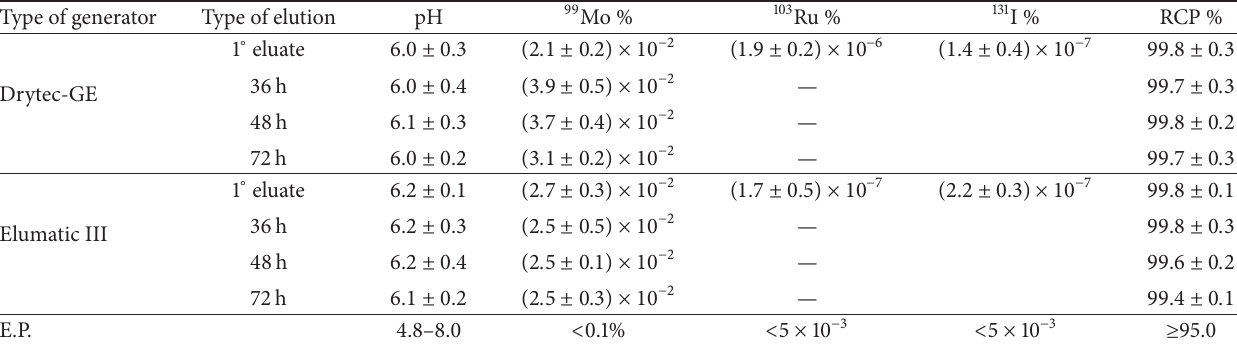
Table 2: pH, 99 Mo, 103 Ru, and 131 I amounts and radiochemical purities (mean ± standard deviation) of the evaluated generators’ elutions. Type of generator